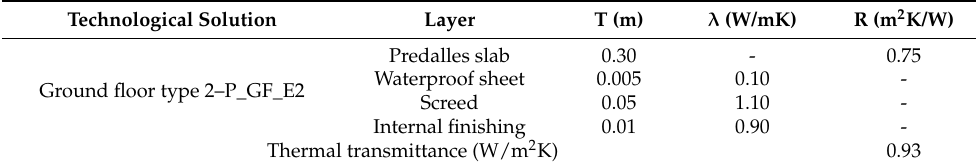
Table A2. Existing ground floor stratigraphy (P_GF_E2).